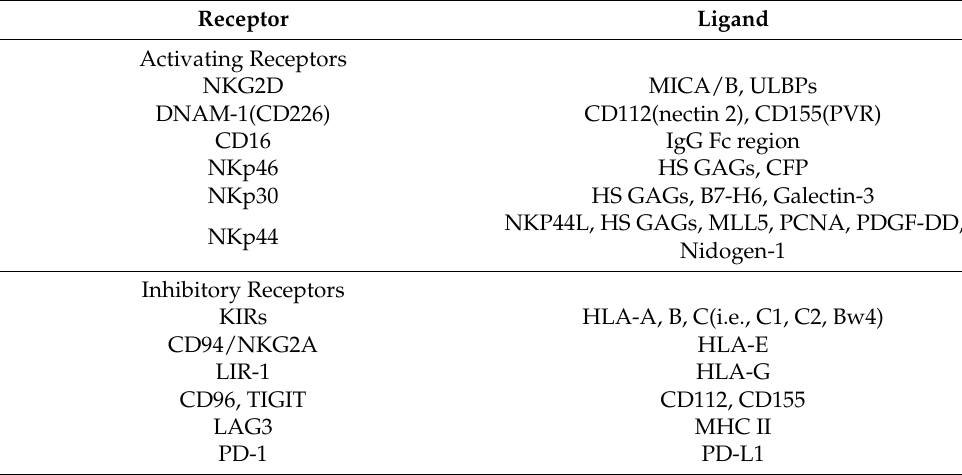
Table 1. Human NK cells receptors and their